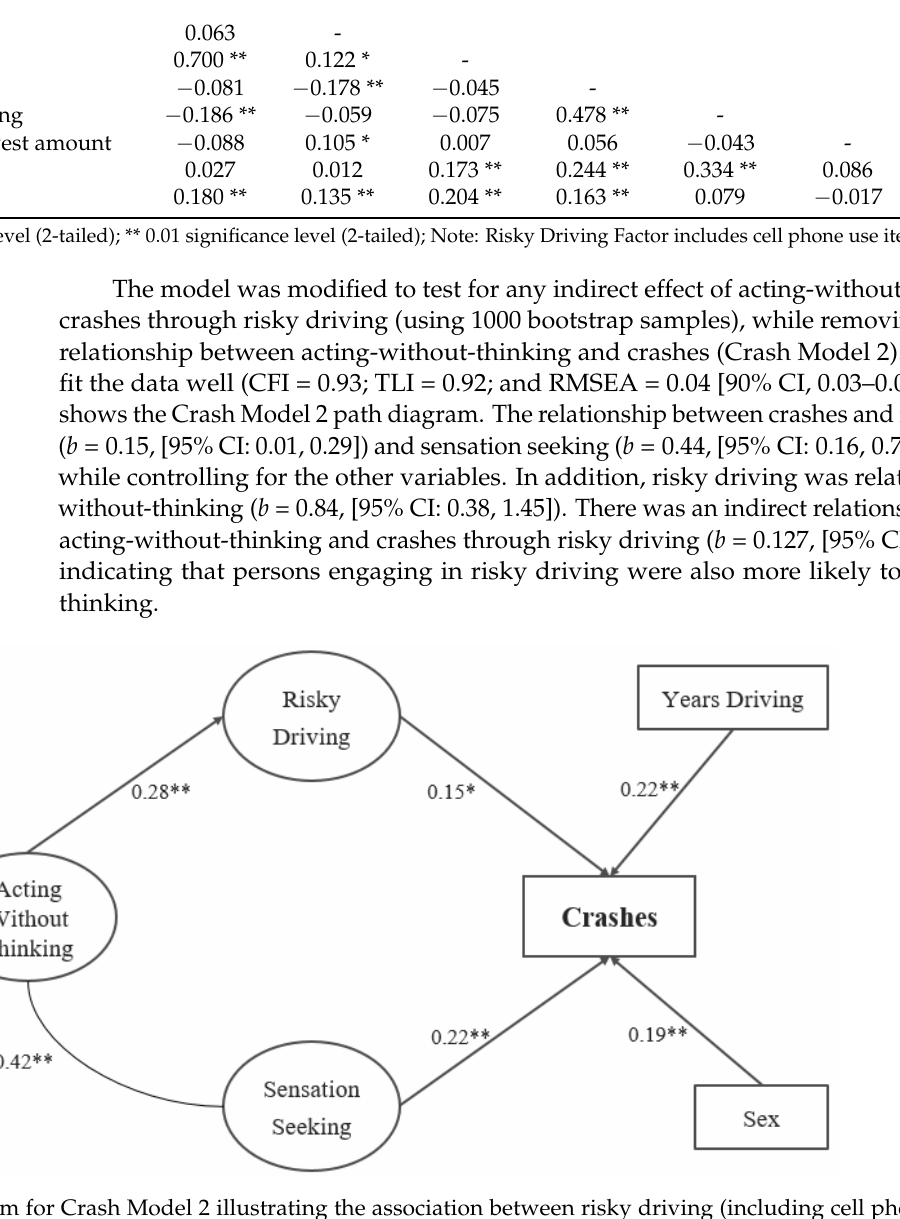
Figure 1. Path diagram for Crash Model 2 illustrating the association between risky driving (including cell phone use), sensation seeking, and crashes. Note: straight lines indicate direct regression paths, with standardized beta values in the SEM model. The curved connector indicates the standardized estimate of correlation between variables. * indicates significance at the p < 0.05 significance level, with ** representing significance at the p < 0.01 level.